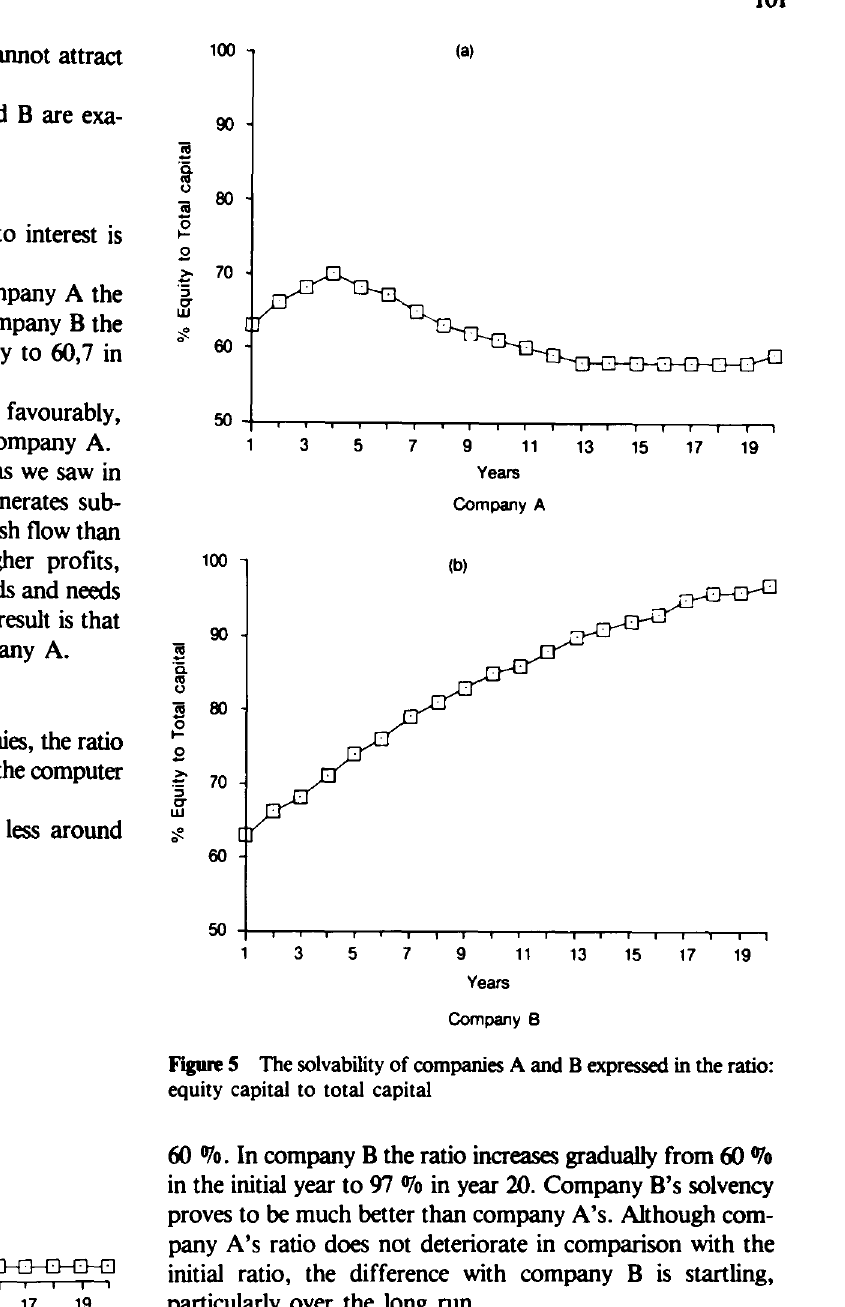
Figure S The solvability of companies A and B expressed in the ratio: equity capital to total